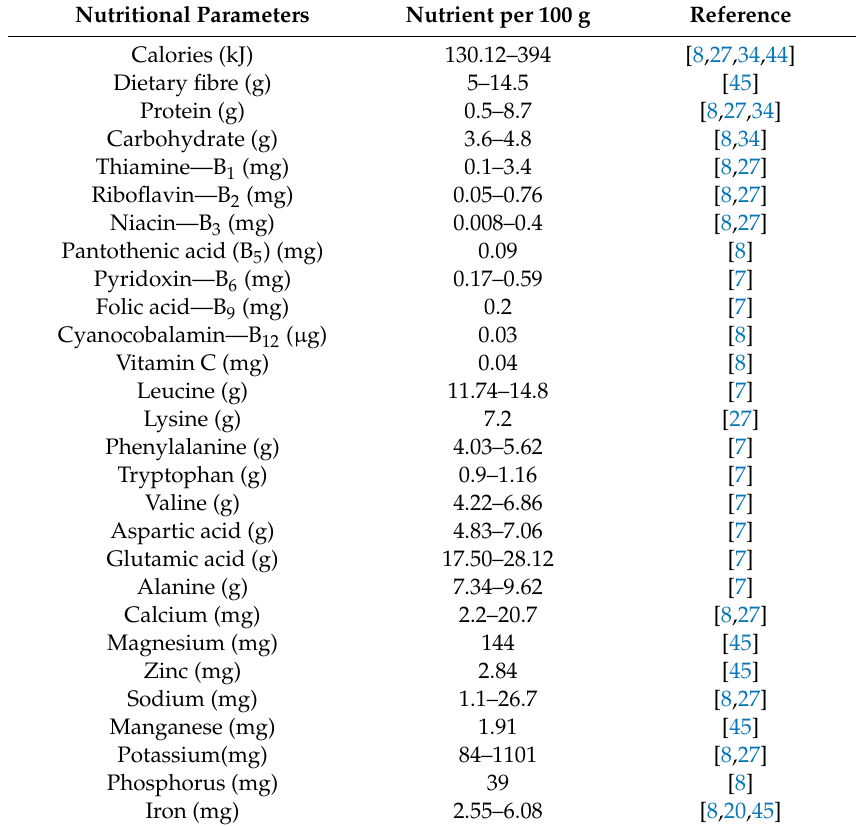
Table 3. The nutritional composition of umqombothi